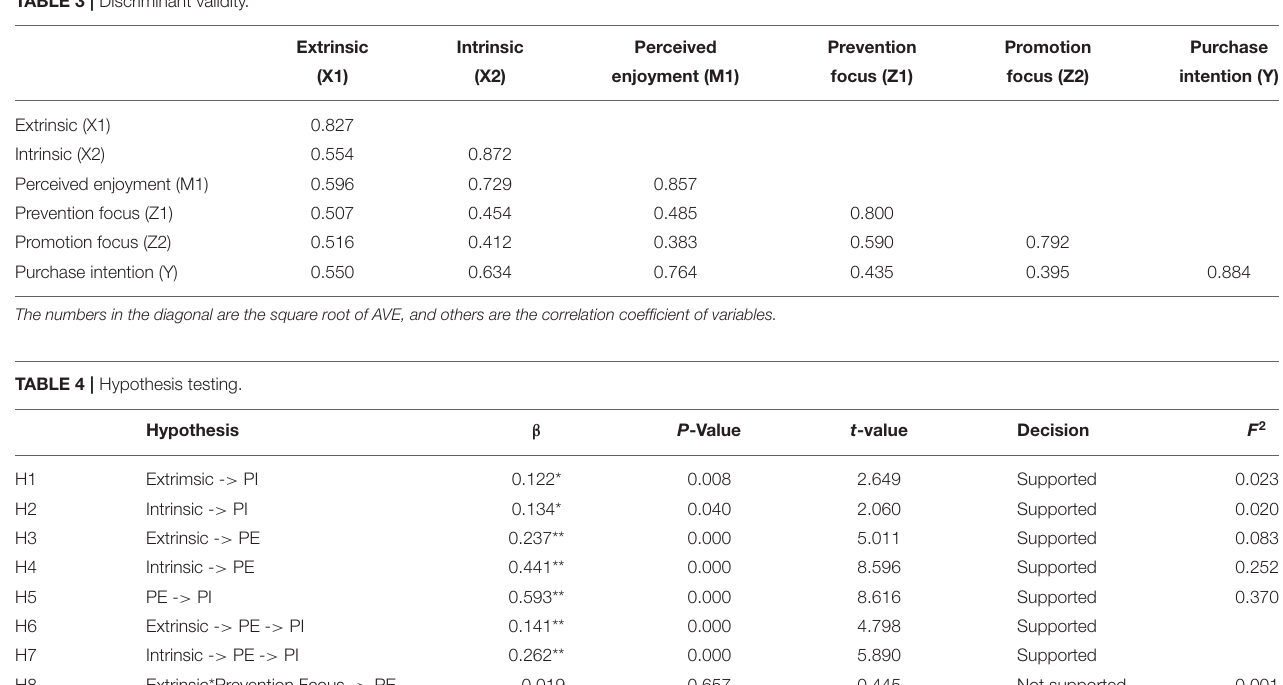
TABLE 3 | Discriminant validity.